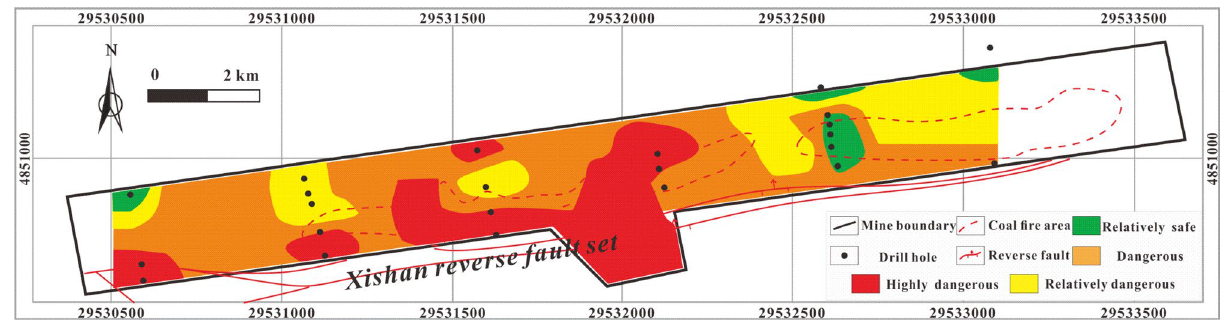
Figure 12. Thematic map of SO 4 2− concentration in MAPGIS software.